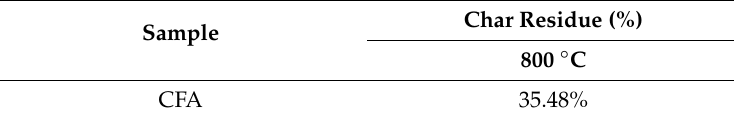
Figure 7. TGA curve of the CFA (ETPMP).